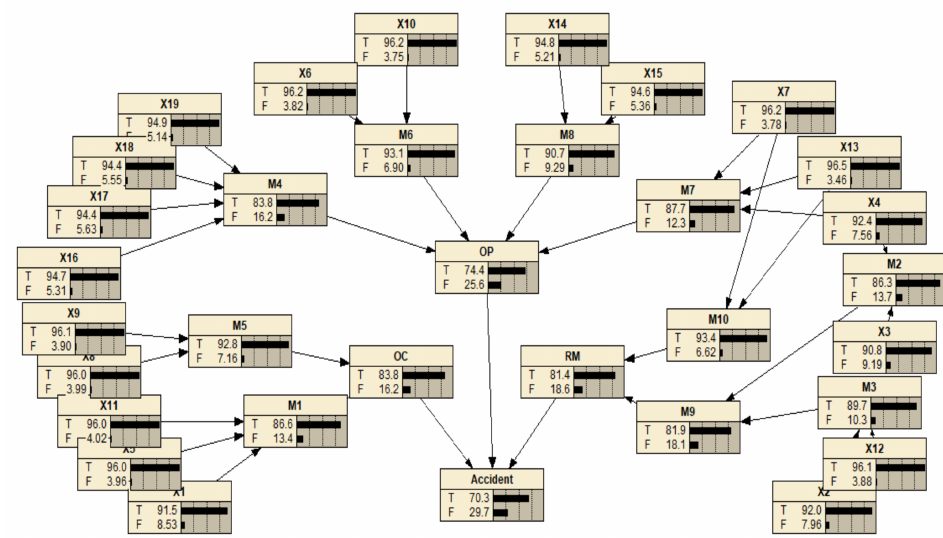
Figure 9. The prior probability distribution of nodes in the developed Bayesian network